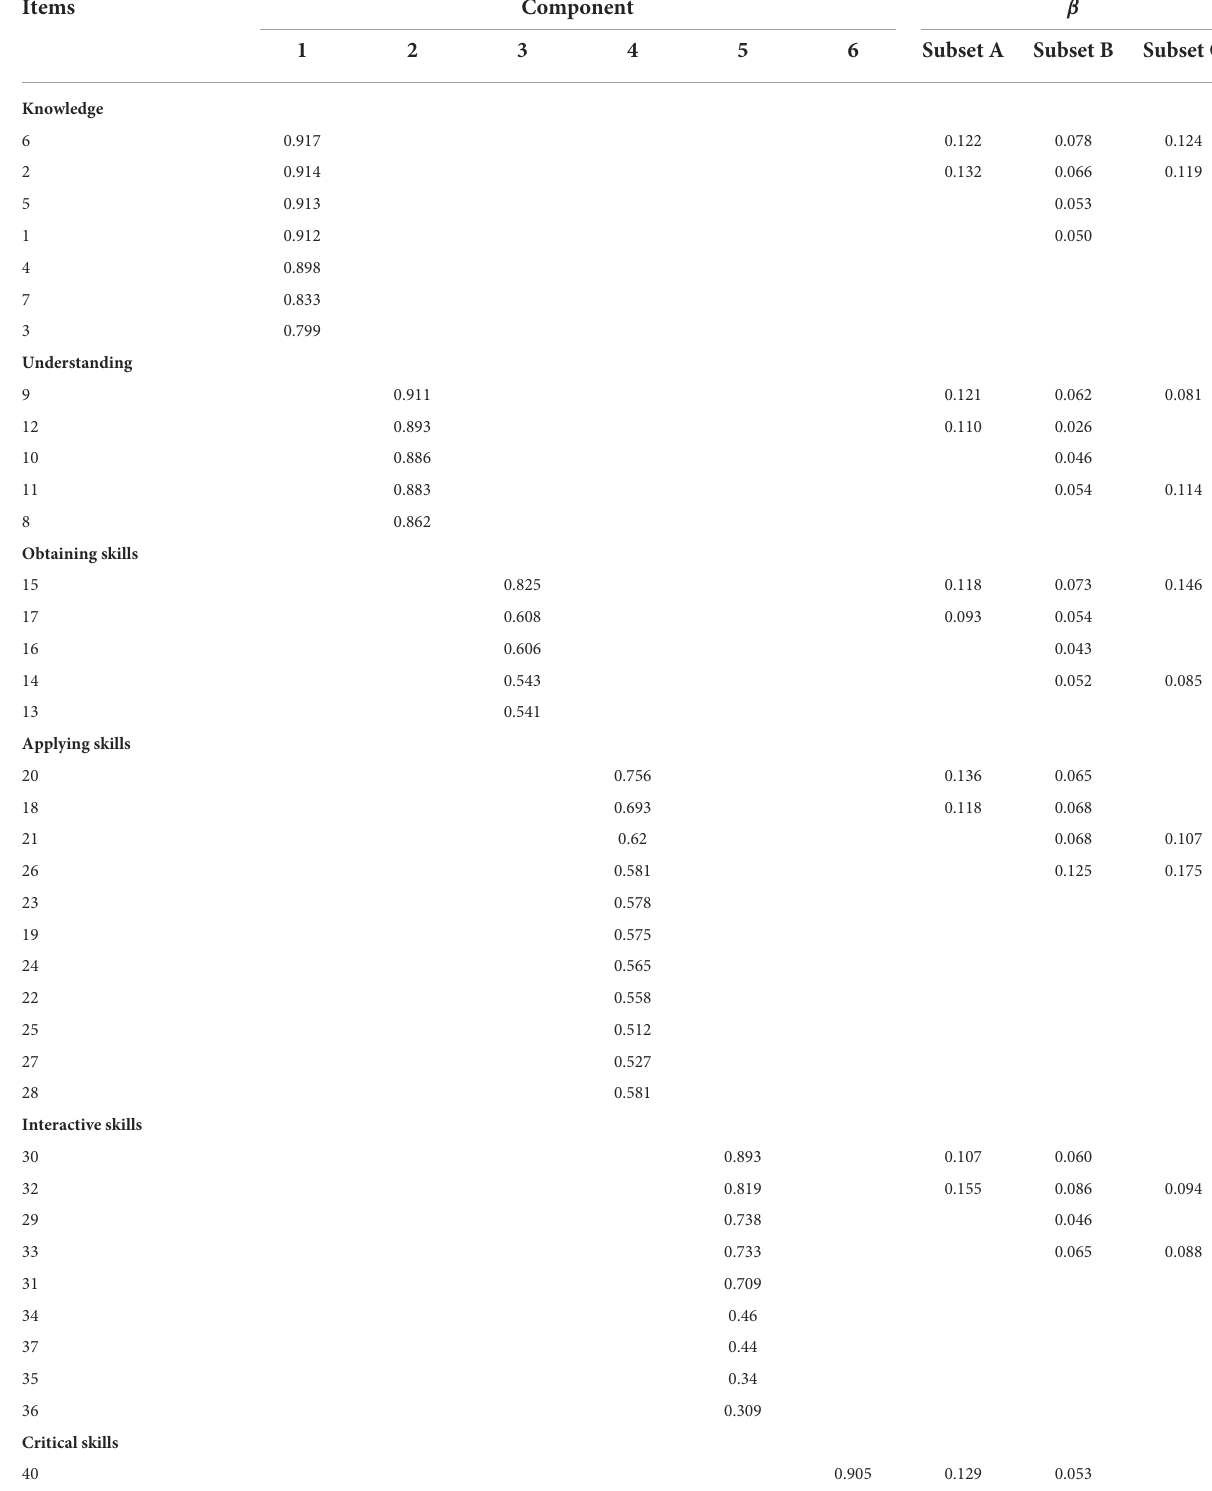
TABLE 2 Results of factor analysis and linear regression analysis of the 24-item subset (subset A) and the two 12-item short-form subsets (subset B and C) from the first dataset ( N 1 =